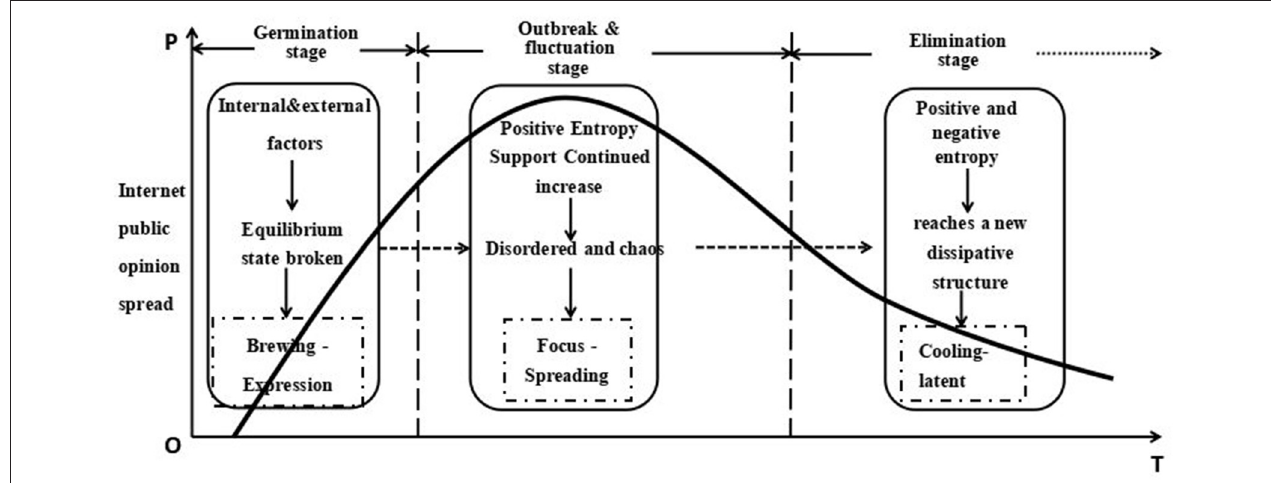
FIGURE 1 | The process of dissipative structure formation of Internet public opinion diffusion.